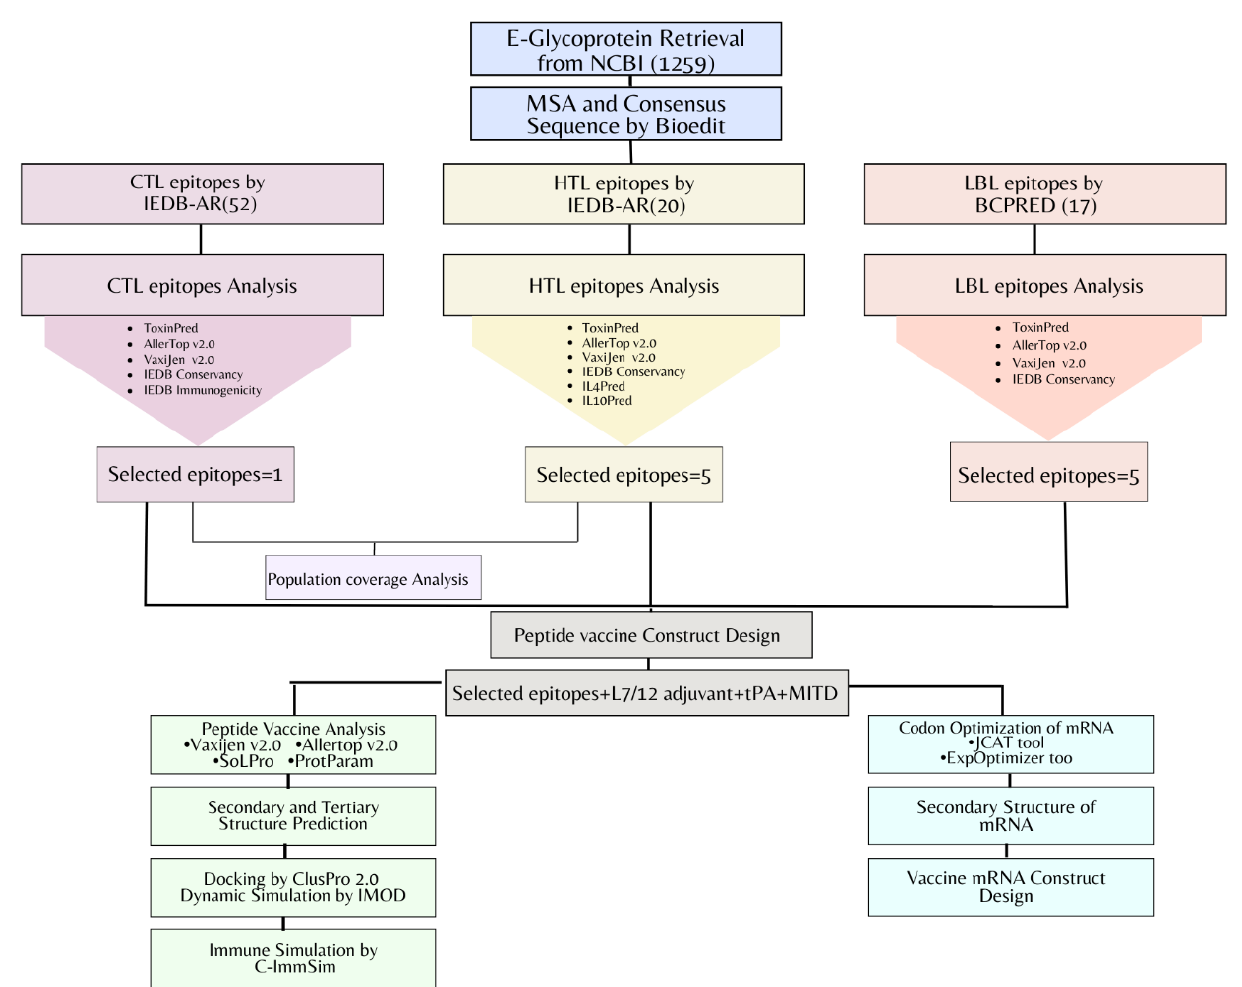
Figure 1. Flowchart of immunoinformatic and reverse vaccinology approaches followed for the potential mRNA vaccine design against CHIKV viral infection.